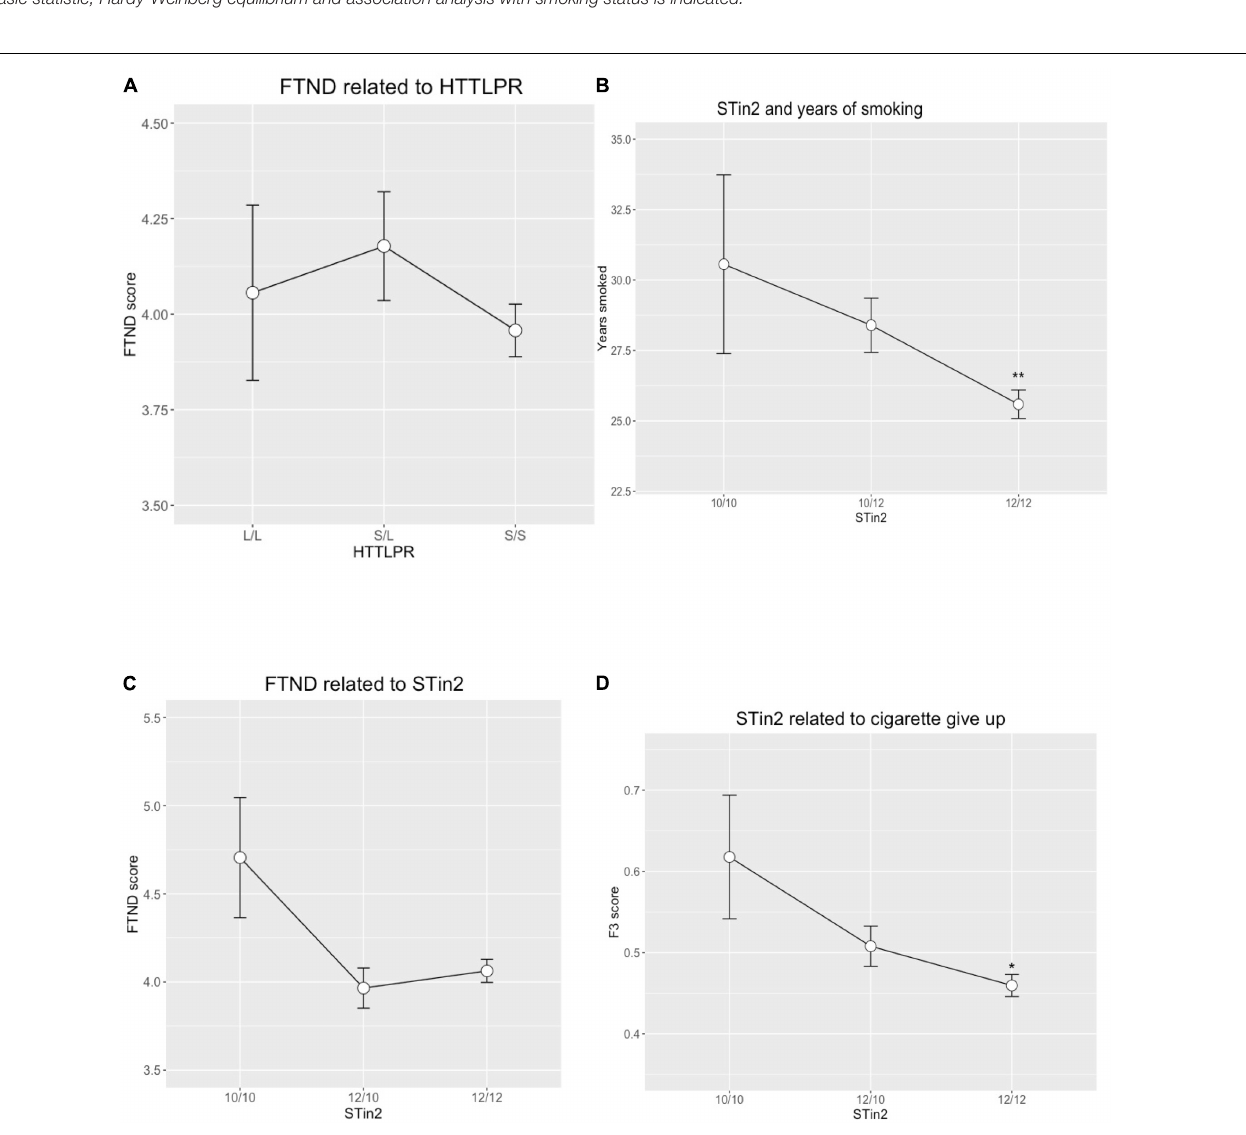
Frontiers in Pharmacology |